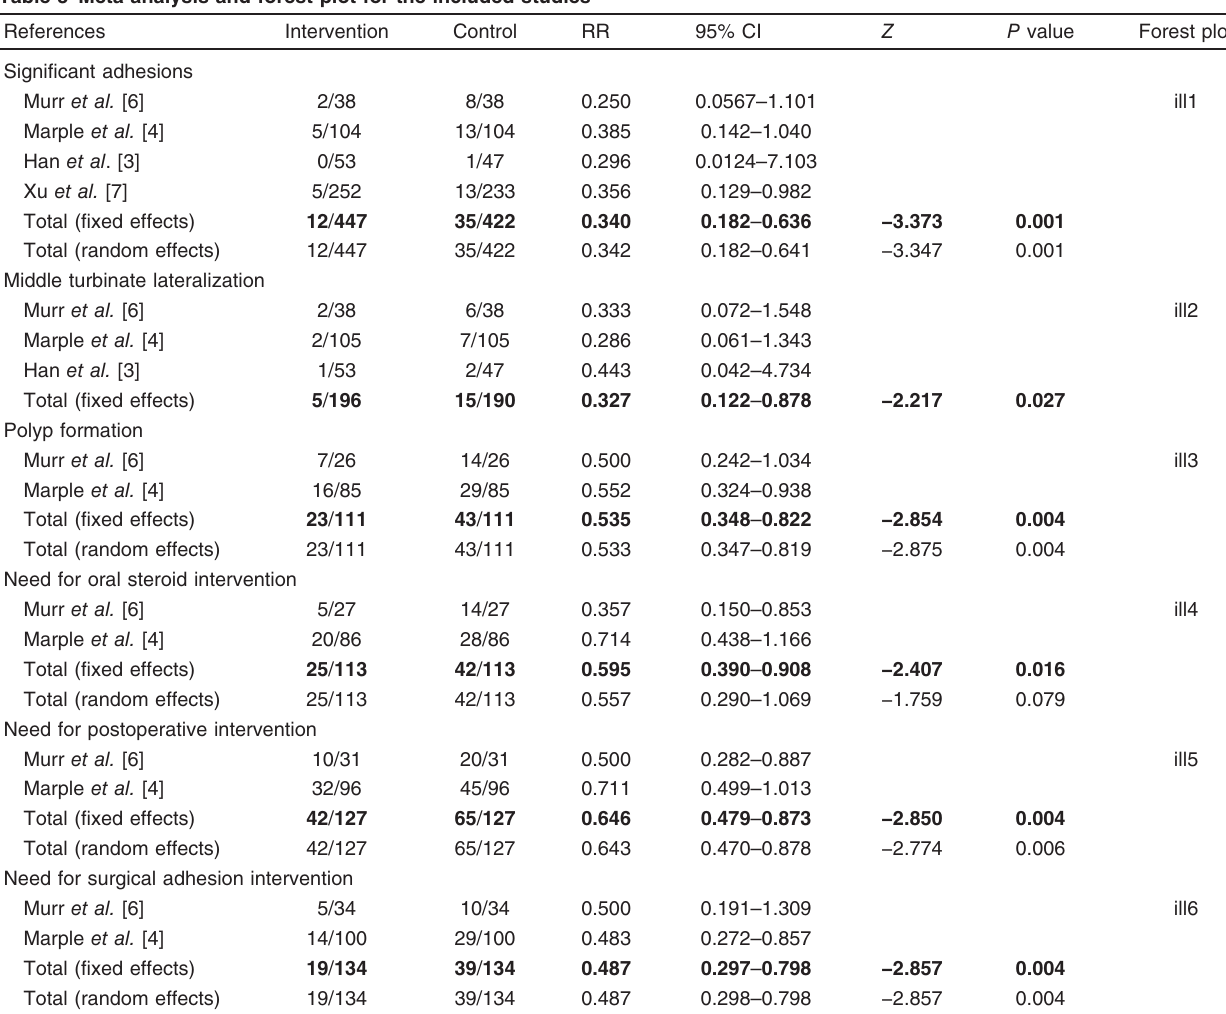
Table 3 Meta-analysis and forest plot for the included